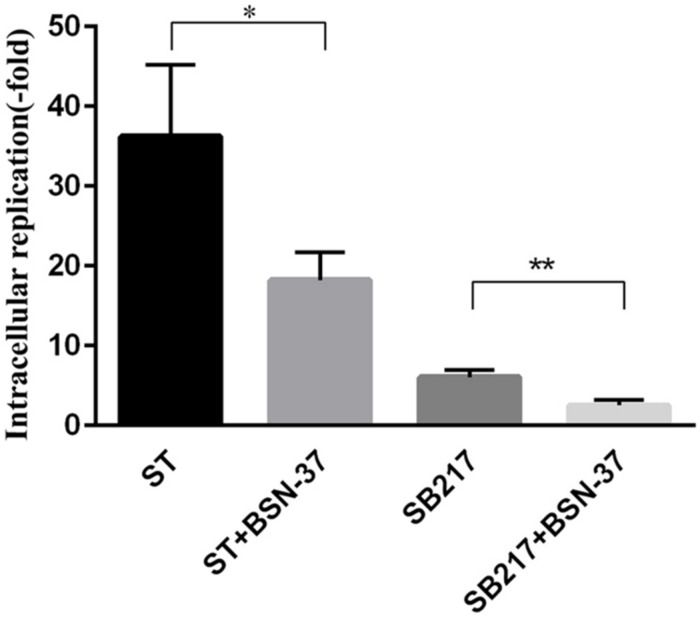
Intracellular replication of ST and SB217 in the presence and absence of BSN-37 in MDCK cells. The concentration of BSN-37 is 400 μg/ml. Error bars represent means ± SEM, n = 3. Statistical significance was defined as follows:∗P < 0.05 and **P < 0.01 (Student’s t-test).